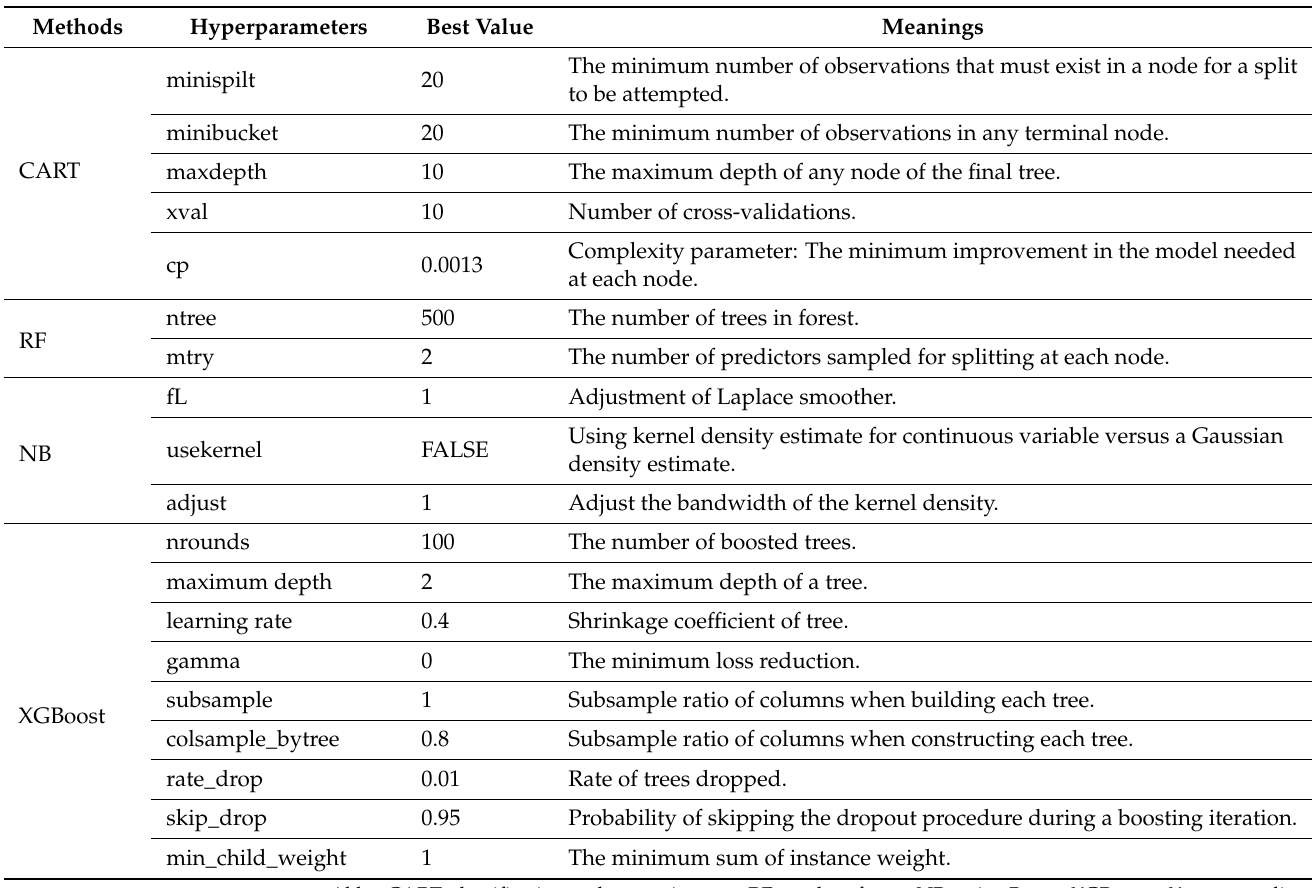
Table 3. Summary of the values of the hyperparameters which train the best NB, RF, CART, and XGBoost